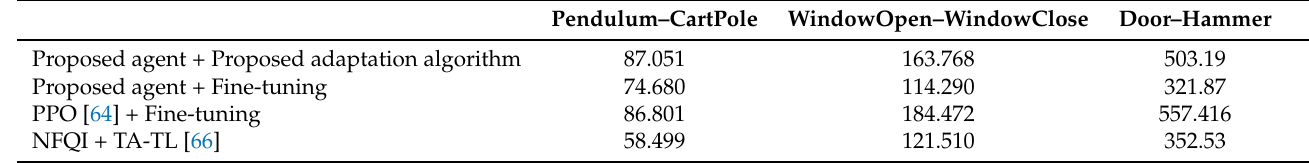
Table 6. The training time (s/epoch) of the proposed task adaptation